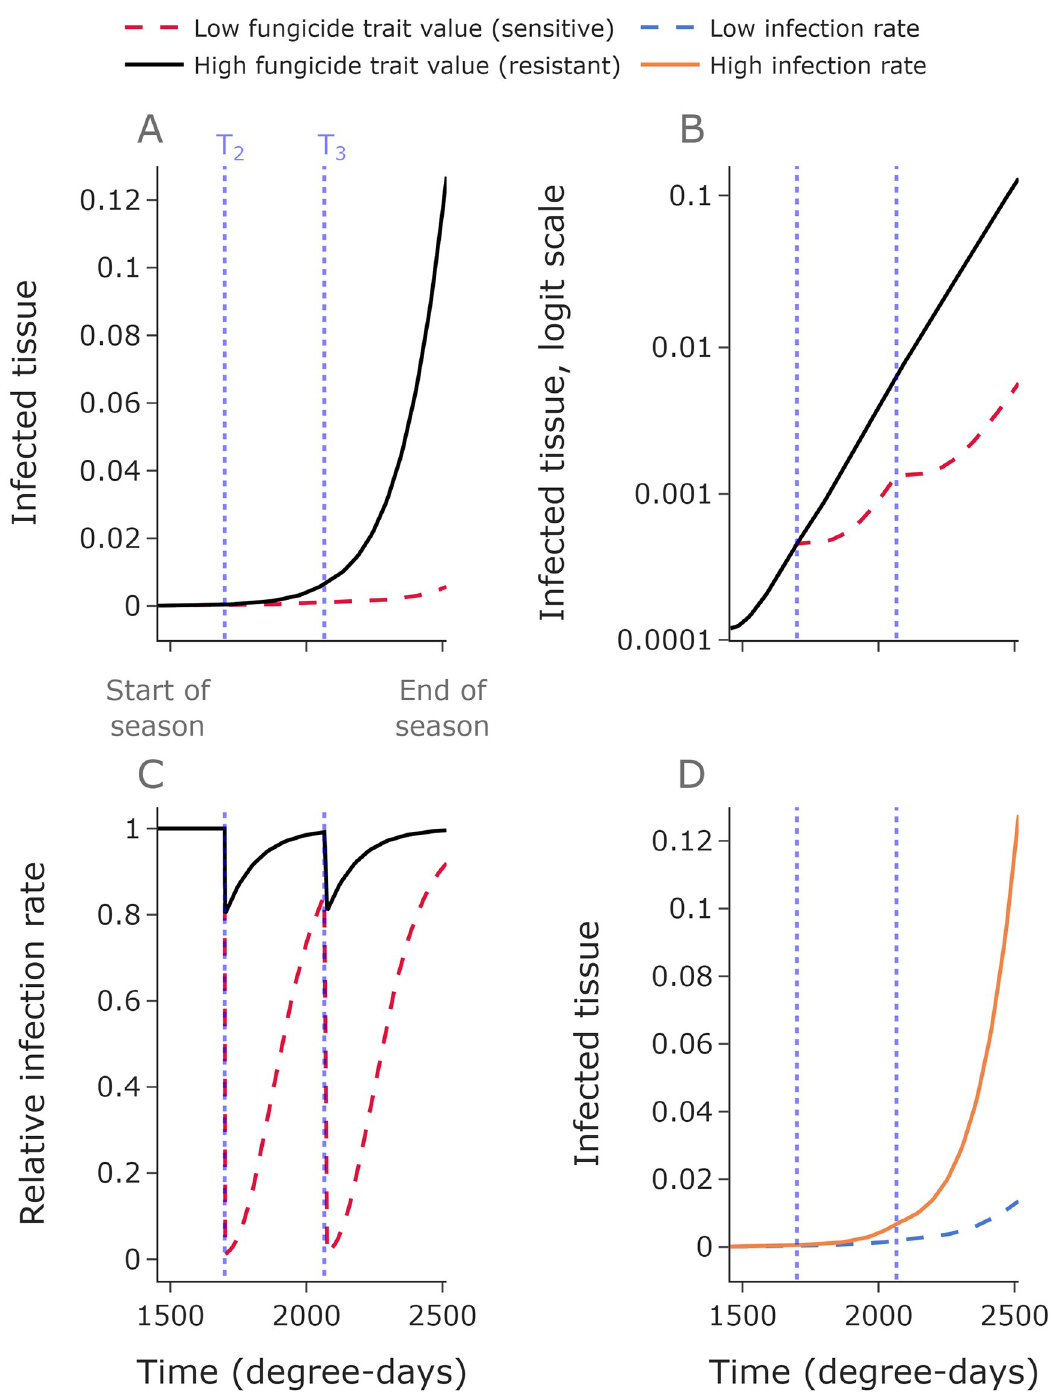
Fig 1. The density of infected tissue depends on the degree of fungicide resistance and infection rate. The dotted blue lines show the two fungicide application times used here. The density of infected tissue is much greater for a pathogen strain with a high fungicide trait value (i.e. more resistant) than for one with a low fungicide trait value (i.e. more sensitive)—see panels A,B . Panel B shows the same disease progress curves on a logit scale (if p 2 (0; 1) is the density of infected tissue, then its logit is logit( p )= log 10 ( p /1 − p )), and shows how disease progression is approximately logistic (i.e. linear on a logit scale). Panel C shows how the relative infection rate varies depending on the fungicide trait values and as the fungicide concentration decays following applications. The baseline infection rate β 0 affects the disease progress curve; high β 0 values give greater infected tissue than low β 0 values ( D ). Parameter values: A,B,C : β 0 = 0.008 degree-days -1 , I 0 = 0:01, low trait value = 0.01, low trait value = 0.8. D : low β 0 = 0.006 degree- days -1 , high β 0 = 0.009 degree-days -1 , I 0 = 0.01, trait value = 0.4. The mutation proportion in all panels is 0. Here n https://doi.org/10.1371/journal.pcbi.1010969.g001 PLOS Computational Biology | https://doi.org/10.1371/journal.pcbi.1010969 March 28,